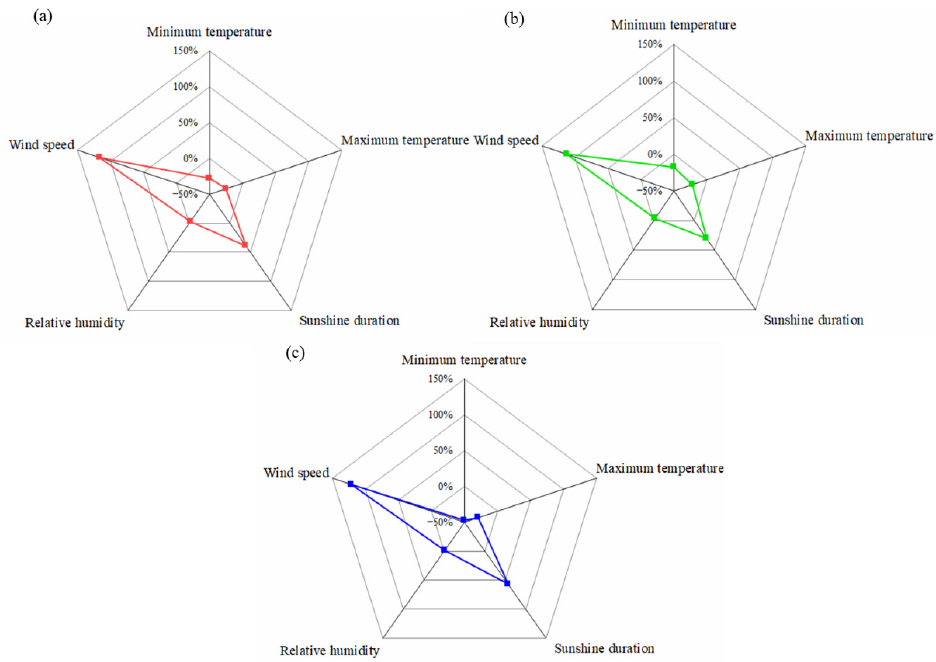
Figure 6. Contribution rate of meteorological factors to crop water requirement variation in the lower reaches of the Yellow River Basin. ( a - c ) Toal water requirement, winter wheat, and summer maize, respectively.